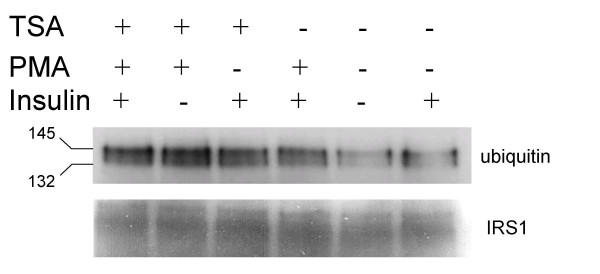
IRS-1 ubiquitination is not altered by acetylation. MCF-7 cells were treated with PMA, TSA and insulin as described for Figure 4 and immunoprecipitated IRS-1 was western blotted for the presence of ubiquitin (upper panel) and IRS-1 (lower panel). The molecular mass of the immunoprecipitated ubiquitinated protein and IRS-1 protein is indicated.